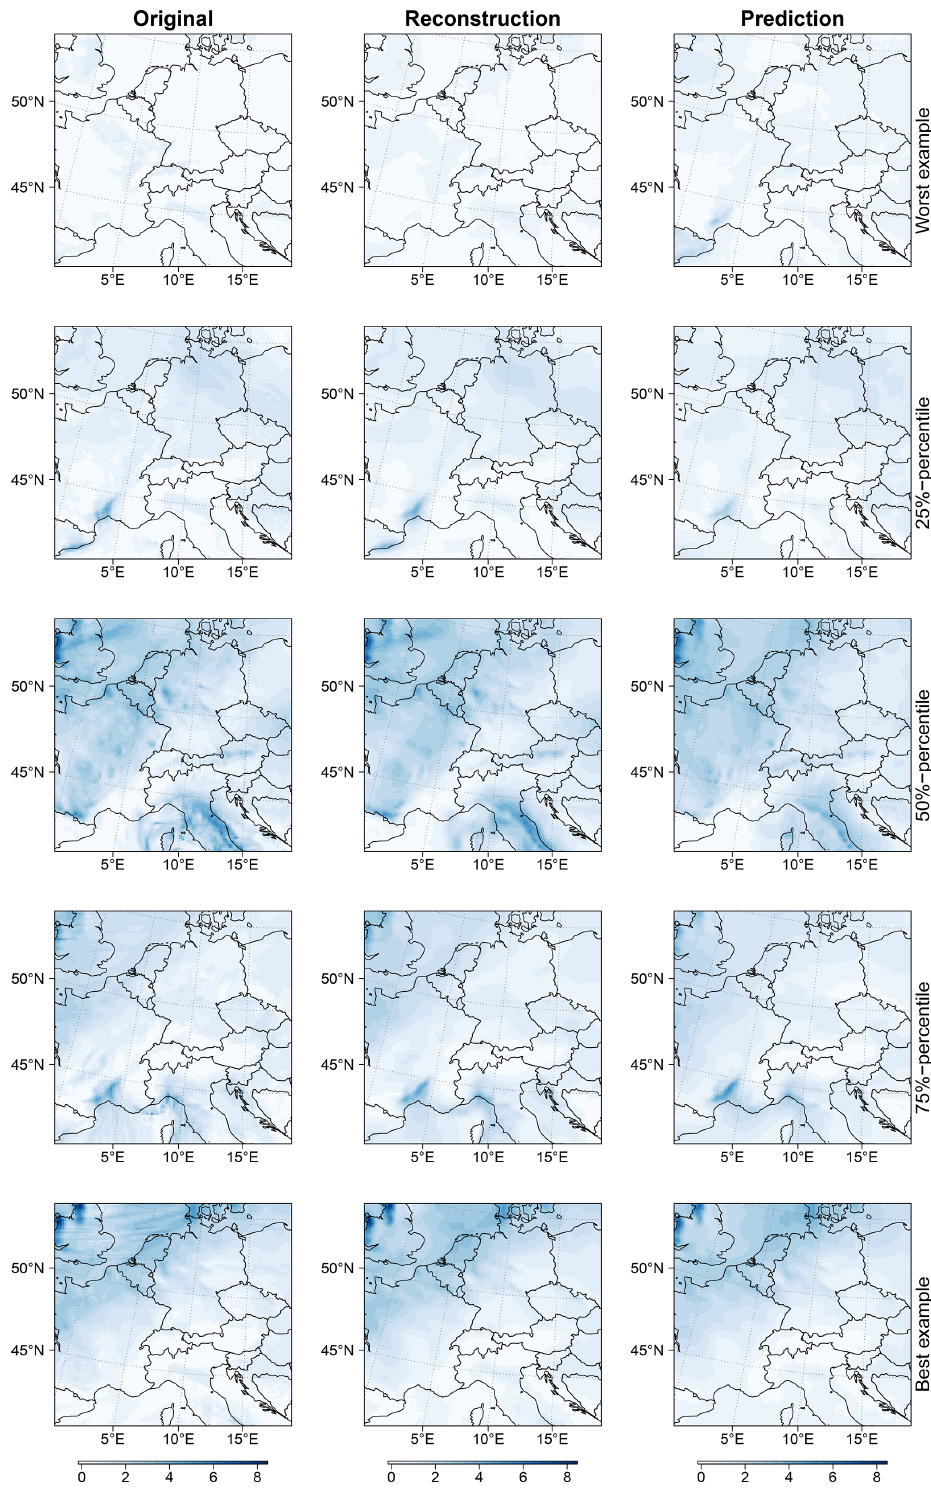
Figure 3. Examples of (i) original precipitation fields (left column), (ii) reconstructions (centre column), and (iii) predictions (right column). The examples are chosen such that the R 2 value of the prediction increases from top to bottom: the first row shows the worst example in the holdout dataset, the last row shows the best example, and the remaining rows show examples at the 25th, 50th, and 75th percentiles, respectively. For better visibility, data are square-root transformed. Hence, the units are